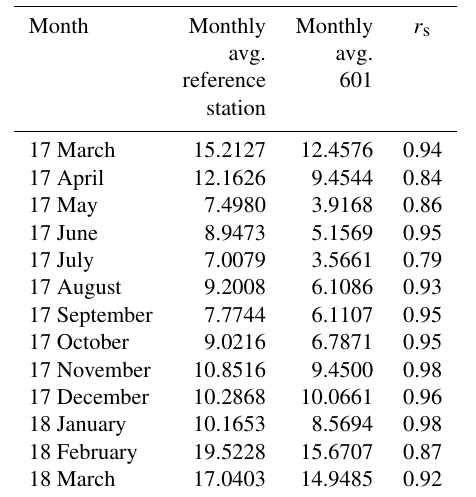
Figure 7. Monthly average PM and relative-humidity values in Römerberg. Table 2. Correlation coefficient ( r s ) of the reference station Schim- melstrasse and the sensor